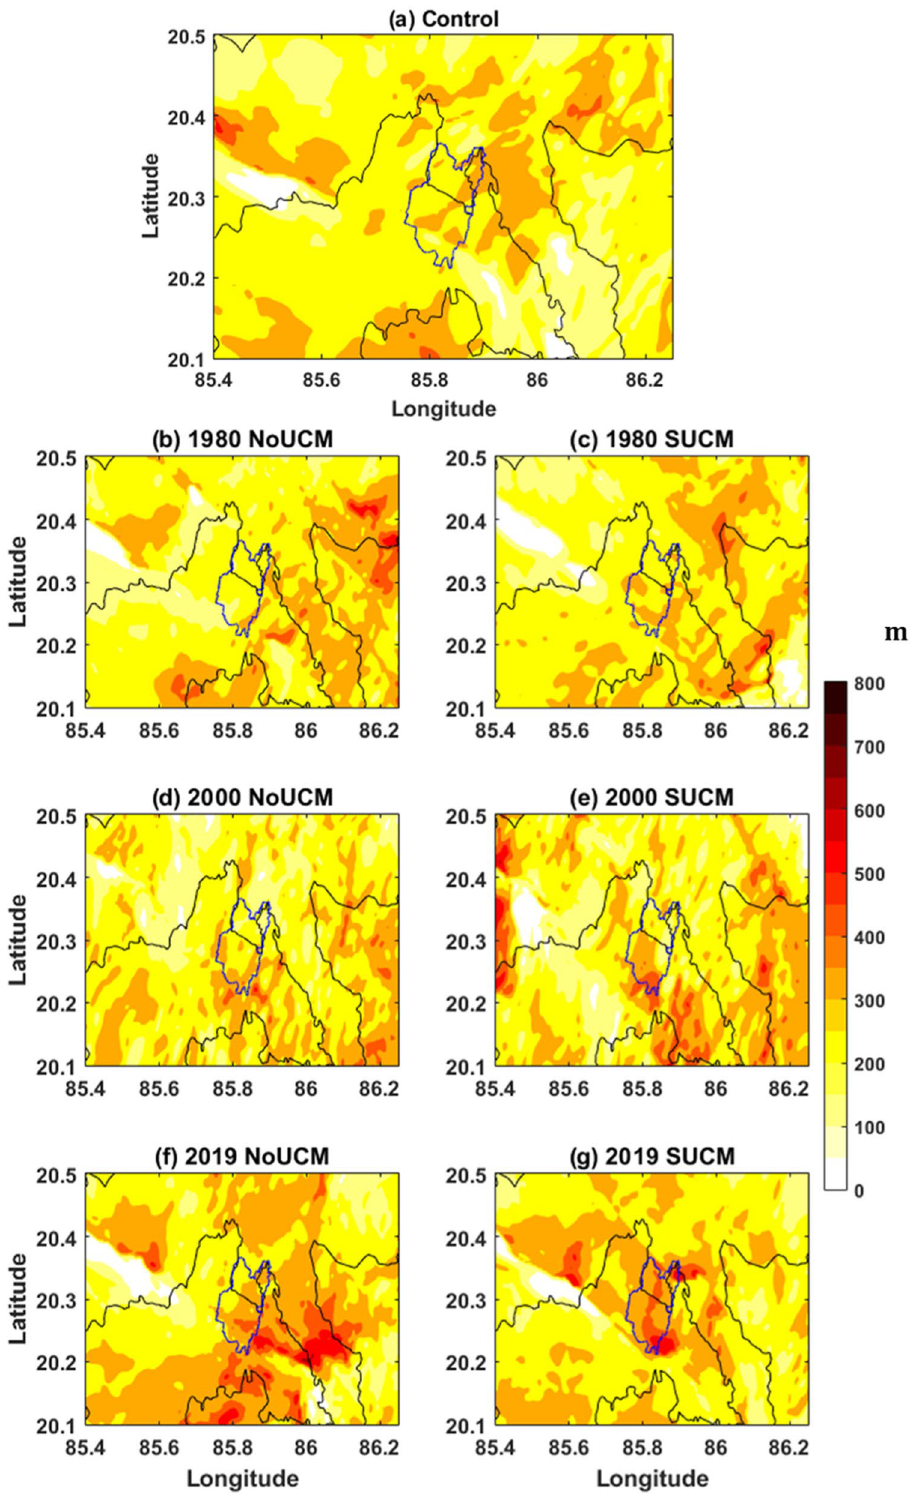
Fig. 10 Planetary boundary layer height (m) for 20072018 case a control run, b 1980 NoUCM, c 1980 SUCM, d 2000 NoUCM, e 2000 SUCM, f 2019 NoUCM, and g 2019